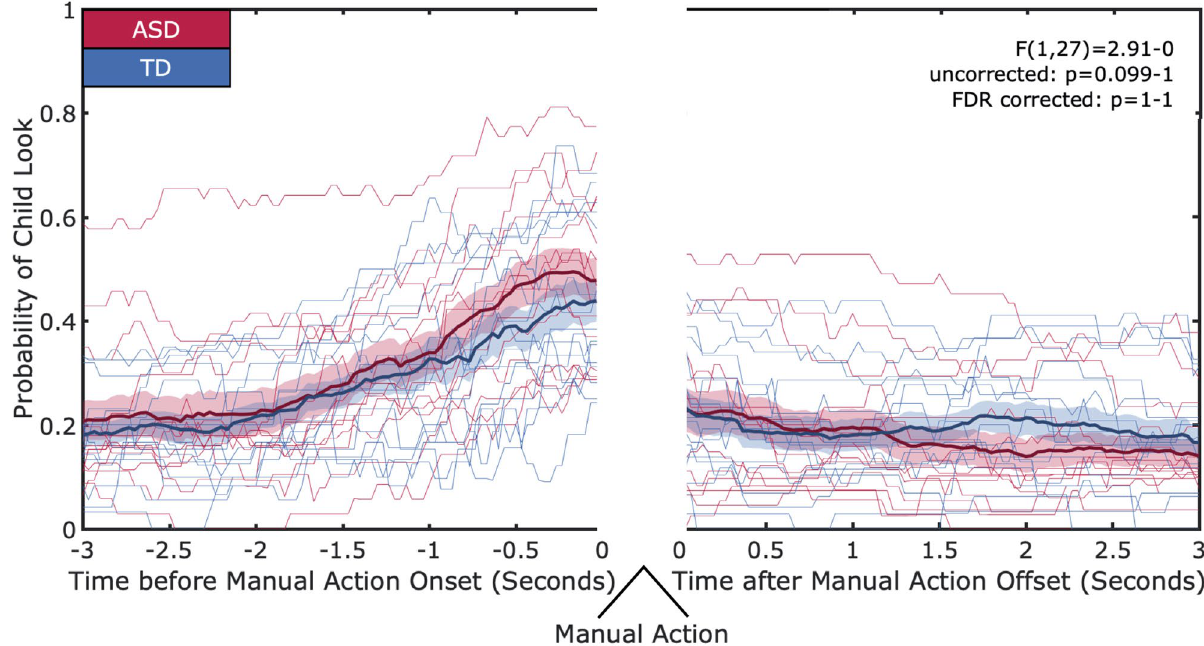
Figure 5. Hand-Eye Coordination. Each individual is represented by a thin line. The bold lines represent the group means, and the shaded region represents the standard error. The x-axis shows 3s before the onset of a manual action and 3s after the offset of a manual action. The y-axis shows the probability that the children are looking at the in-hand toy. There are no differences between groups in the likelihood of looking to the in-hand toy in the 3s before and after the manual